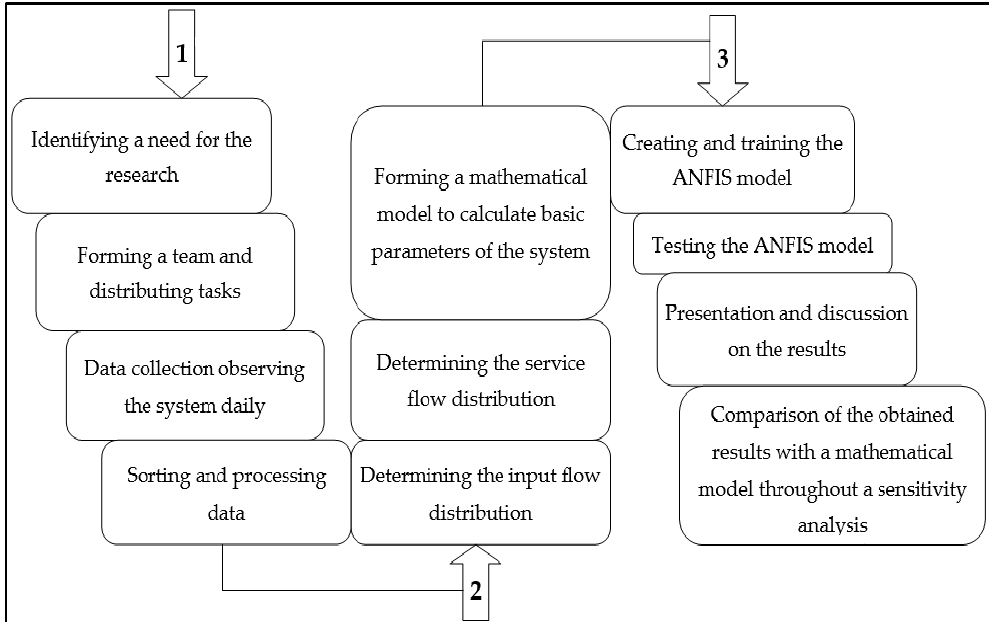
Figure 1. Diagram of the research flow.